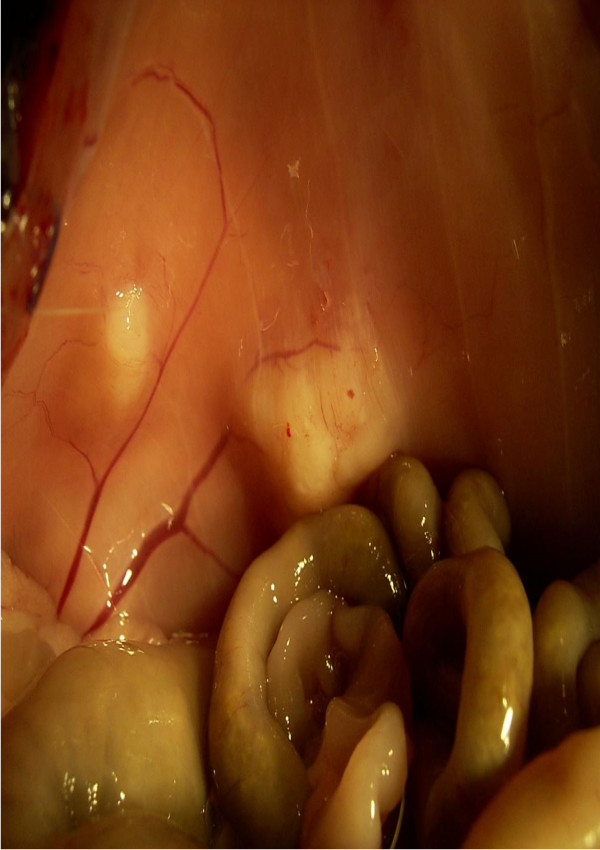
Small tumor load in HIPEC group (group II).